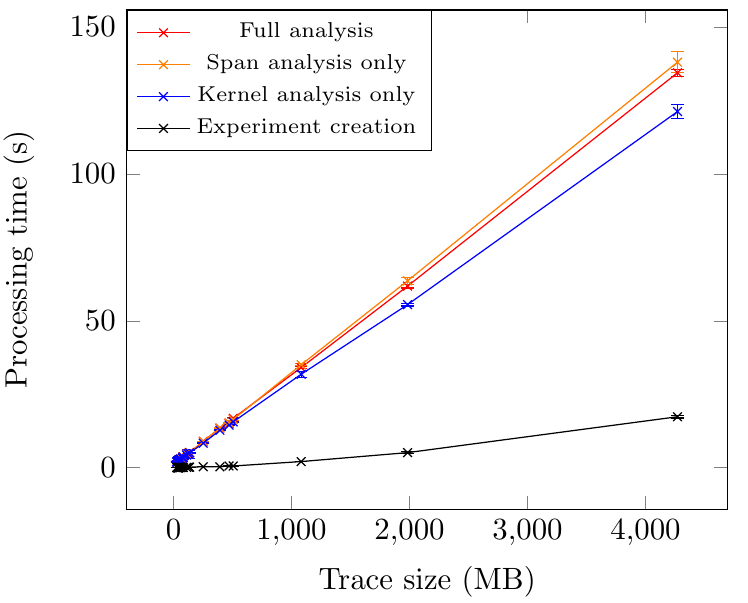
Figure 10. Execution time of our critical path analysis of requests. Considering the test traces used, our analysis seems to scale linearly with the trace size. The execution time is very reasonable for moderately large